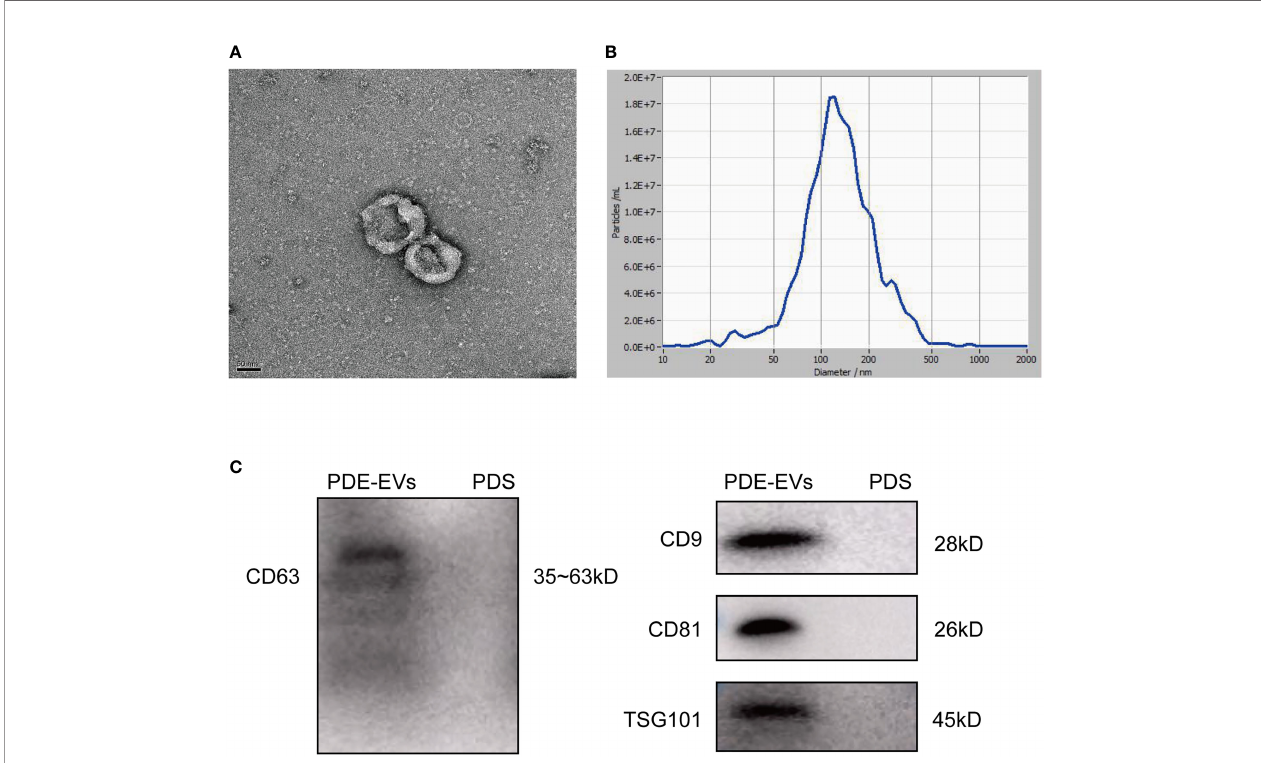
FIGURE 1 | Characteristics of PDE-derived EVs. PDE-EVs were isolated from concentrated overnight PDE by differential ultracentrifugation. Unused 2.5% peritoneal dialysis solution (PDS) following ultracentrifugation was as a negative control. (A) The typical shape and morphology of PDE-EVs isolated by ultracentrifugation under TEM. (B) The diameters of PDE-EVs were measured by NTA. (C) Western blotting of PDE-EVs markers CD9, CD63, CD81, TSG101. n = 2. The results shown are from one representative of three independent experiments. TEM, Transmission electron microscopy; NTA, Nano tracking